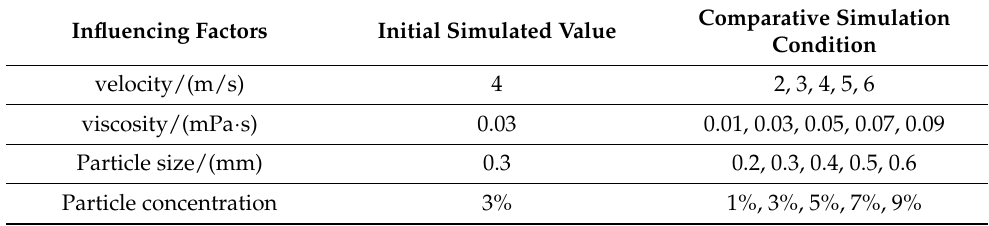
Table 1. Simulation scheme of influencing factors.